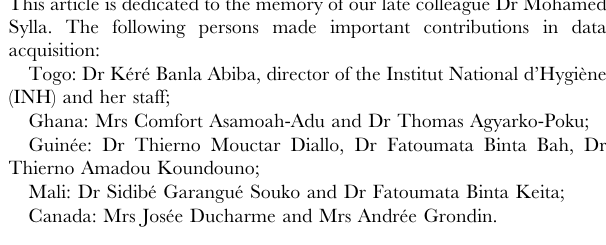
Table S1 Primers used for various pathogens. (DOC) Table S2 Frequency of associations between various bacterial species or genera. (DOC) Table S3 Prevalence of micro-organisms according to age. (DOC) Table S4 Prevalence of micro-organisms according to self-defined occupation. (DOC) Table S5 Prevalence of micro-organisms according to number of sex partners in the last 3 months. (DOC) Table S6 Prevalence of micro-organisms according to HIV status. Table S7 Correlates of bacterial vaginosis (Nugent score $ 7) in multivariate analysis, excluding patients with an intermediate Nugent score (4–6). Table S8 Correlates of bacterial vaginosis (Nugent score $ 7) in multivariate analysis, excluding patients with an intermediate Nugent score (4–6). Presence of Lactobacillus has been removed from this model. Table S9 Proportion of patients with bacterial vaginosis who reported a complete resolution of vaginal discharge by Day 14. Text S1 Methods used for nucleic acid amplification testing for various bacterial genus or species.